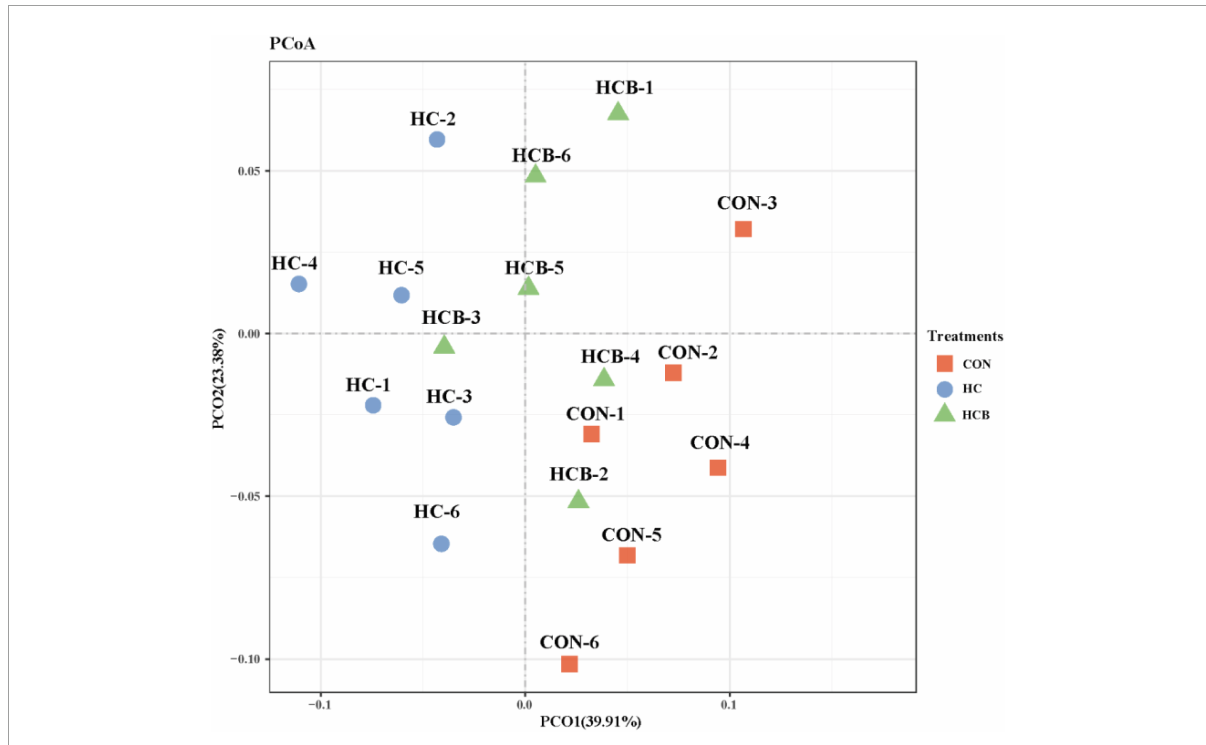
FIGURE1 Principal coordinate analysis (PCoA) on community structures of the rumen microbiota between control treatment and small peptide supplement treatment. CON, control treatment; HC, high-concentrate diet treatment; HCB, high-concentrate diet supplemented with vitamin B1